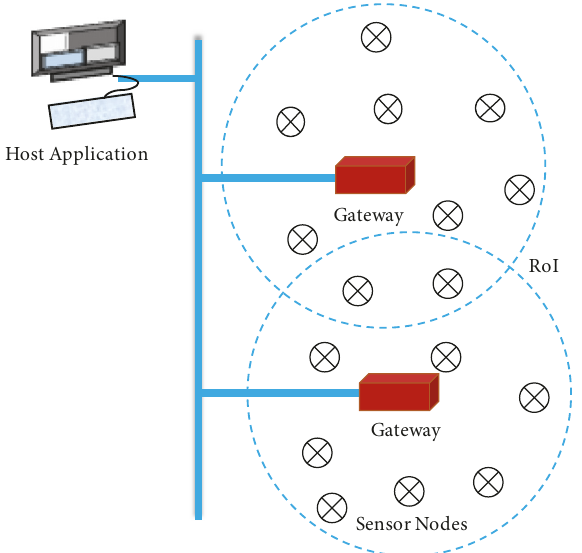
Figure 1: The WirelessHART network is composed of a host application, several gateways, and a number of sensor nodes. The physical information sensed by the sensor nodes is collected by the gateways and then forwarded to the host application for the monitoring and